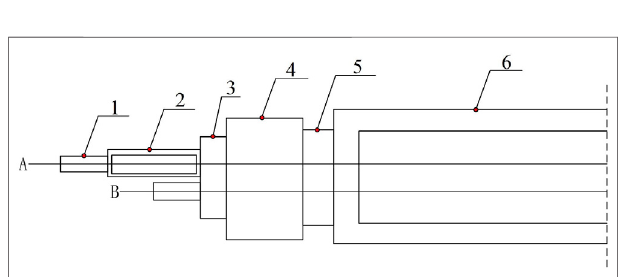
FIGURE 2 | Schematic diagram of tensile test; 1-anti-seismic anchor; 2- cushion block; 3-tool anchor; 4-force sensor; 5-limit plate; 6-tension table.